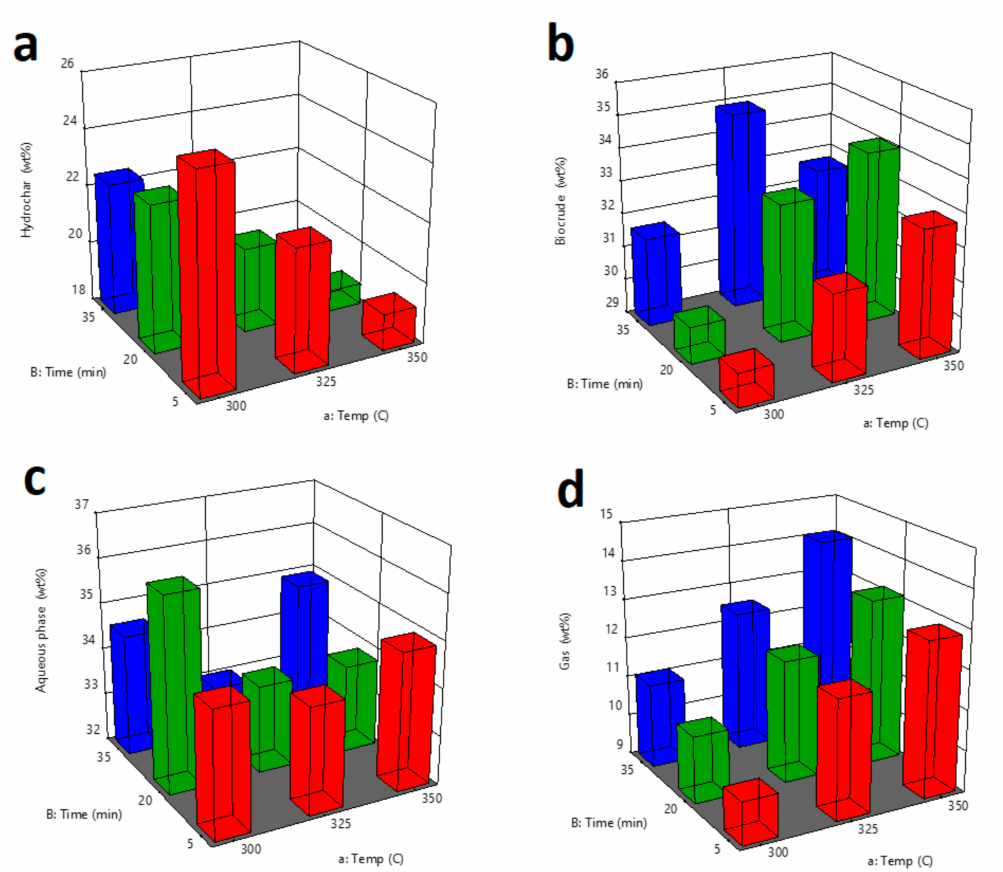
Figure 1. E ff ect of operating parameters on ( a ) hydrochar yield, ( b ) biocrude yield, ( c ) aqueous phase yield, and ( d ) gas